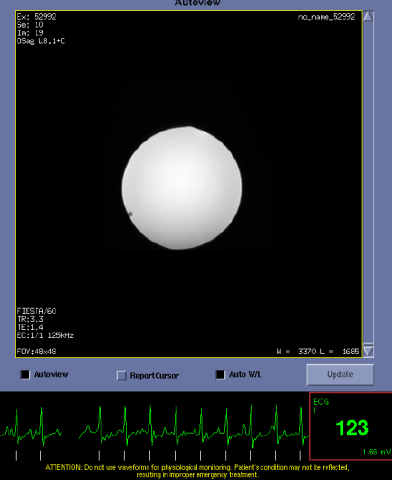
Figure 4. A FIESTA sequence with TR = 3.3 ms, TR = 1.4 ms, NEX = 1, in-plane spatial resolution = 1 × 1 mm, SLT = 5 mm acquired with the cardiac gating signal from the simulated fetal ECG at 123 beats per minute acquired over the 6 m MR compatible leads. The images show no artifacts from the leads or